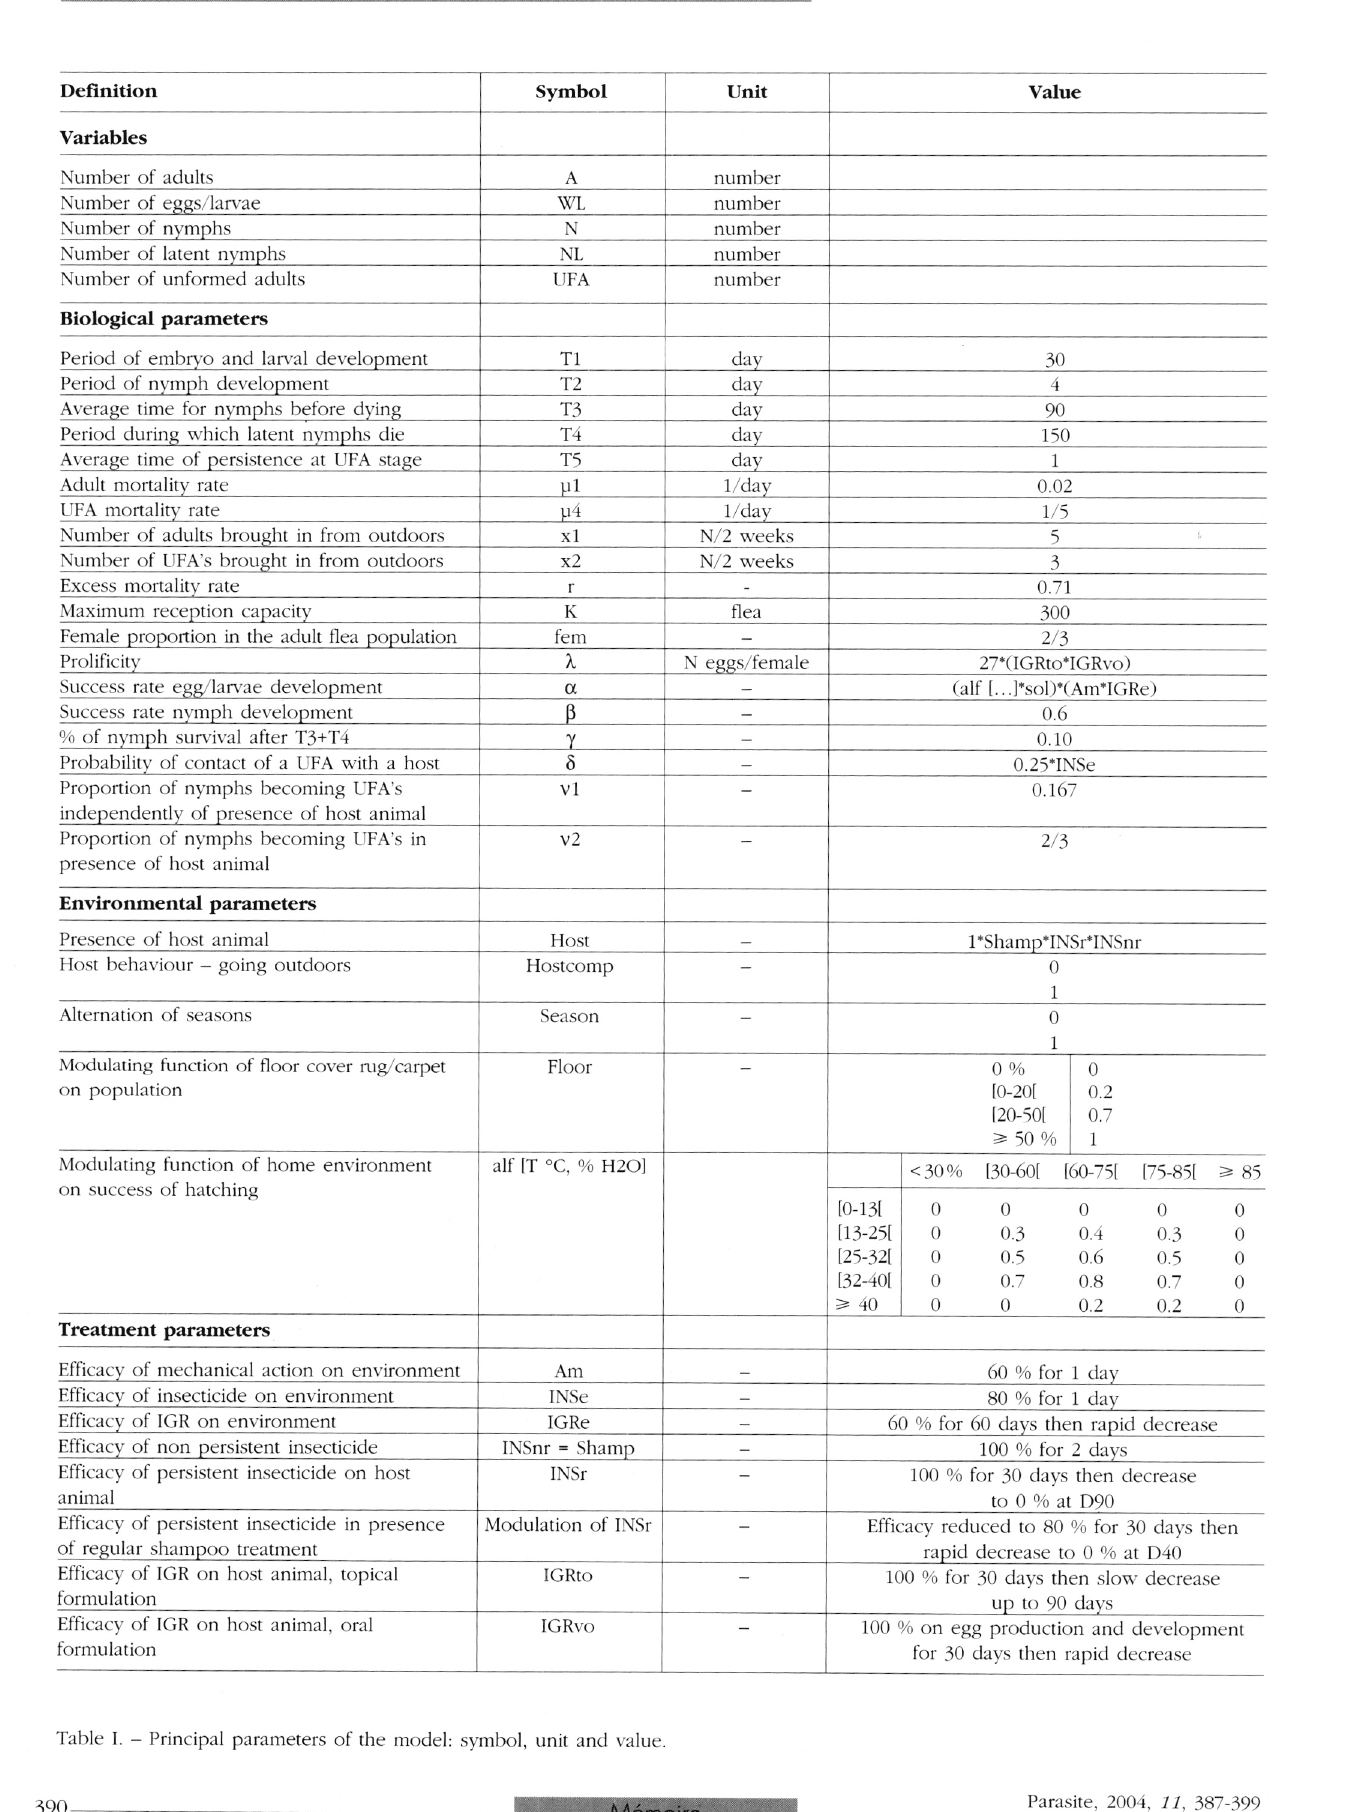
Table I. - Principal parameters of the model: symbol, unit and